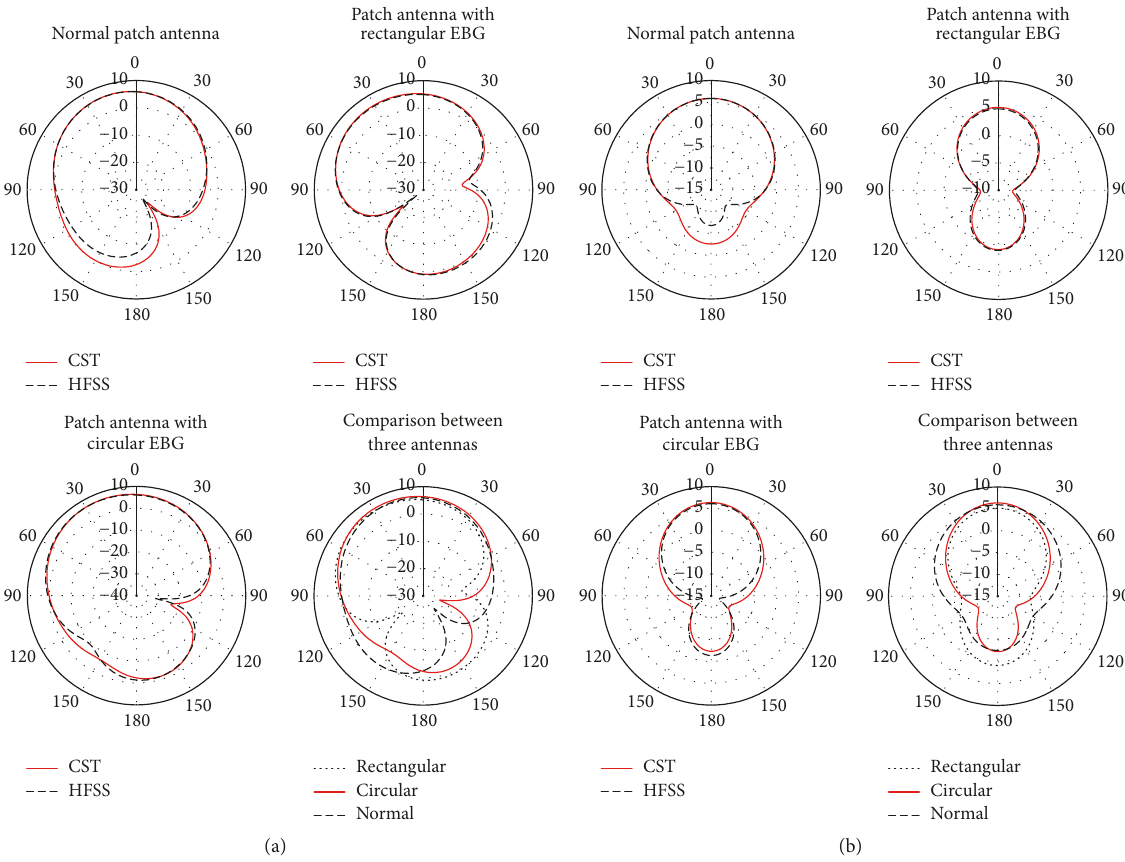
Figure 10: Radiation patterns of the designed antennas at 7.3GHz in (a) 𝐸 -plane and (b) 𝐻 -plane.